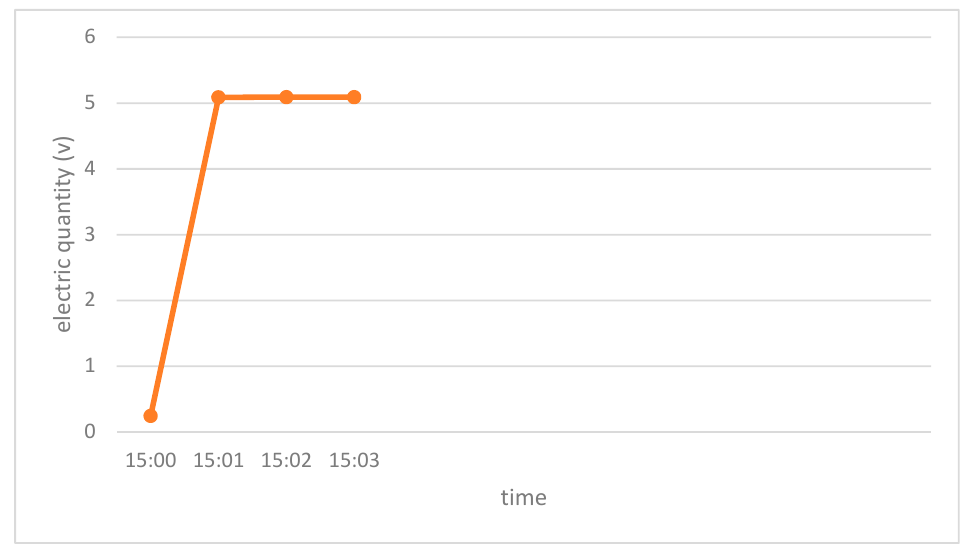
Figure 17. The charge curve of the photovoltaic subtle energy-powered RFID tag adopted in the proposed system. This experiment was conducted in a sunny day. The luminance ranged between 77,000 lux and 85,000 lux during the test period of time. The RFID tag was fully charged at 15:01, and the whole charging process took around 1 min.